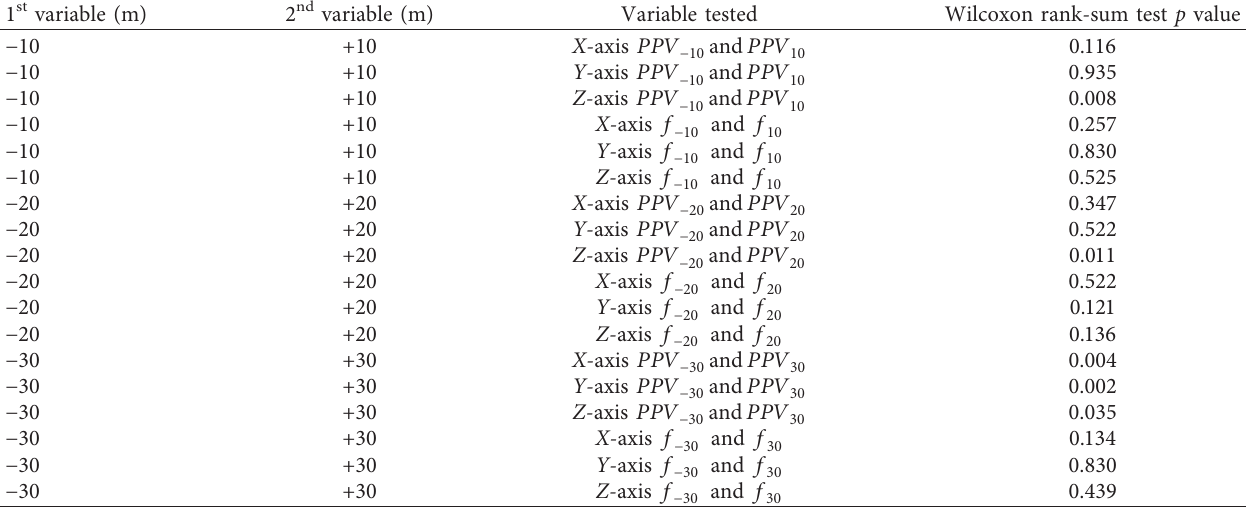
Table 4: Significant tests of difference among pair monitoring points.